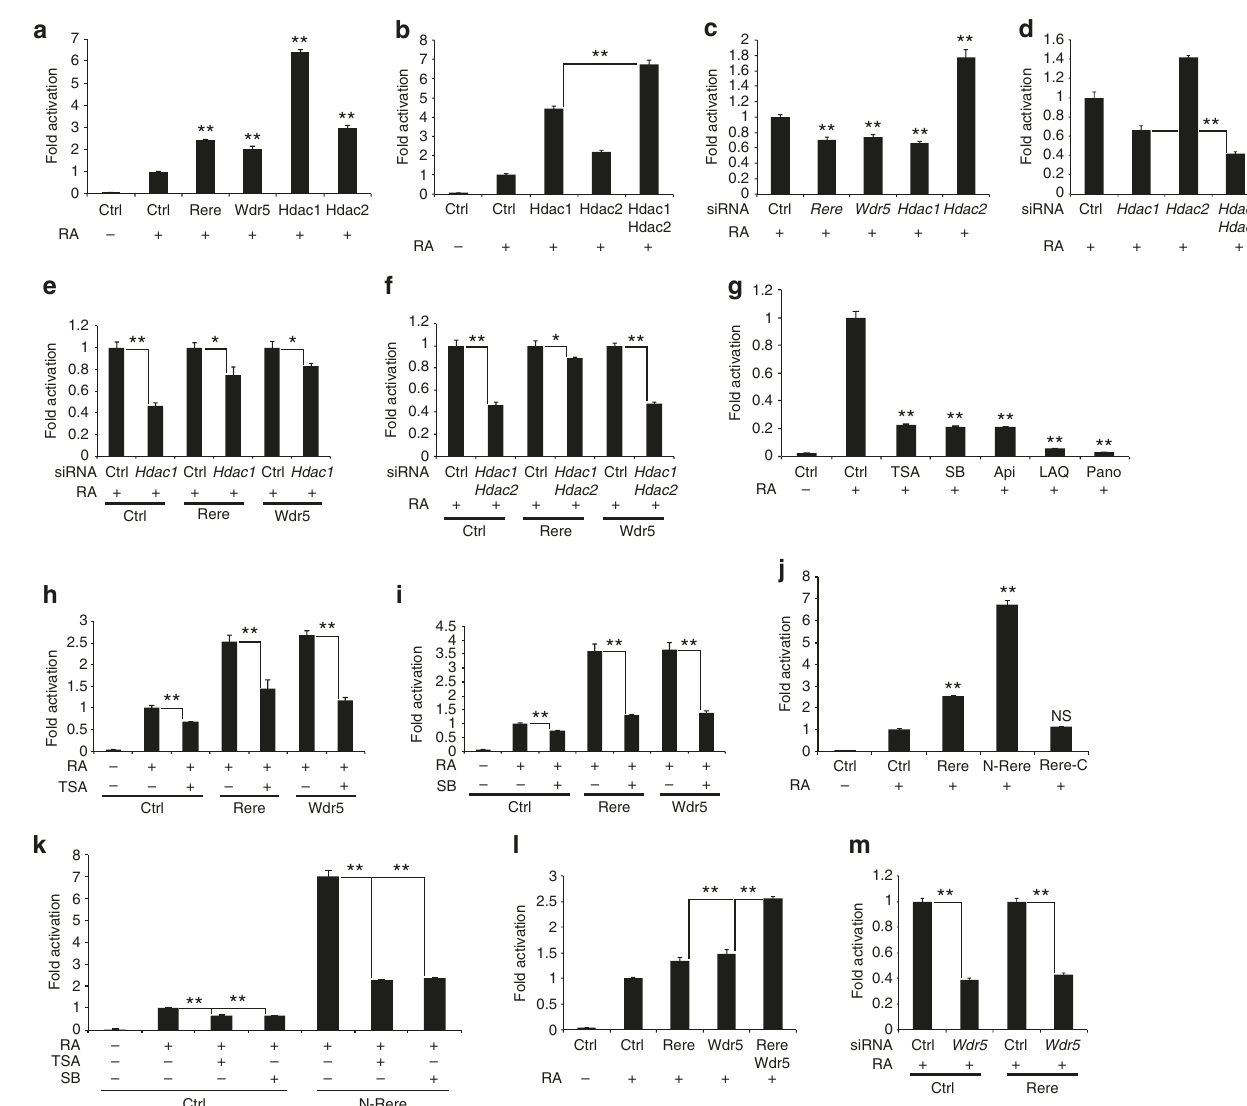
Fig. 2 The WHHERE complex acts as a coactivator for retinoic acid signaling. a - k RARE-Luciferase activity from NIH3T3 cells treated or not with 1 µ M RA for 20h. a Cells transfected with expression plasmids containing Rere, Wdr5 , Hdac1 , or Hdac2 ( n = 4). b Cells transfected with expression plasmids containing Hdac1 , Hdac2 , or both ( n = 4). c Cells treated either with siRNA for Rere, Wdr5 , Hdac1 , or Hdac2 ( n = 4). d Cells treated with siRNA for Hdac1 , Hdac2 or both ( n = 4). e Cells overexpressing Rere or Wdr5 and treated with siRNA against Hdac1 ( n = 4). f Cells overexpressing Rere or Wdr5 and treated with siRNA against both Hdac1 and Hdac2 ( n = 4). g Cells treated with the HDAC inhibitors Trichostatin A (TSA) (60nM), sodium butyrate (SB) (3mM), apicidin (Api) (300 nM), LAQ824 (LAQ) (60nM) and Panobinostat (Pano) (30nM) ( n = 4). h Cells overexpressing Rere or Wdr5 and treated with TSA (30nM) ( n = 4). i Cells overexpressing Rere or Wdr5 and treated with SB (1.5mM) ( n = 4). j Cells transfected with expression plasmids containing Rere , N-Rere ( Rere N-terminal domain) or Rere C ( Rere C-terminal domain) ( n = 3). k Cells overexpressing N-Rere ( Rere N-terminal domain) and treated with TSA (30nM) or SB (1.5mM) ( n = 4). l Cells transfected with expression plasmids containing Rere , Wdr5 , or both ( n = 4). m Cells overexpressing Rere and treated with siRNA for Wdr5 ( n = 4). In all graphs data represent mean ± s.e.m. NS — not signi fi cant, * P < 0.05 and ** P < 0.01. Student ’ s unpaired two-tailed t